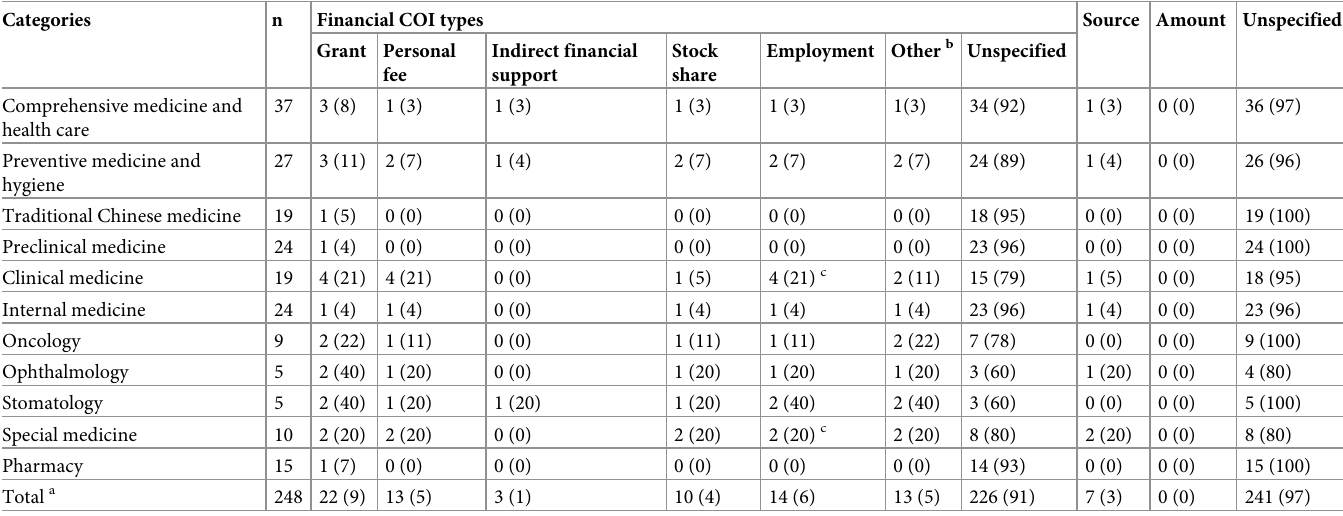
Table 4. Specific items of financial COIs in research [n